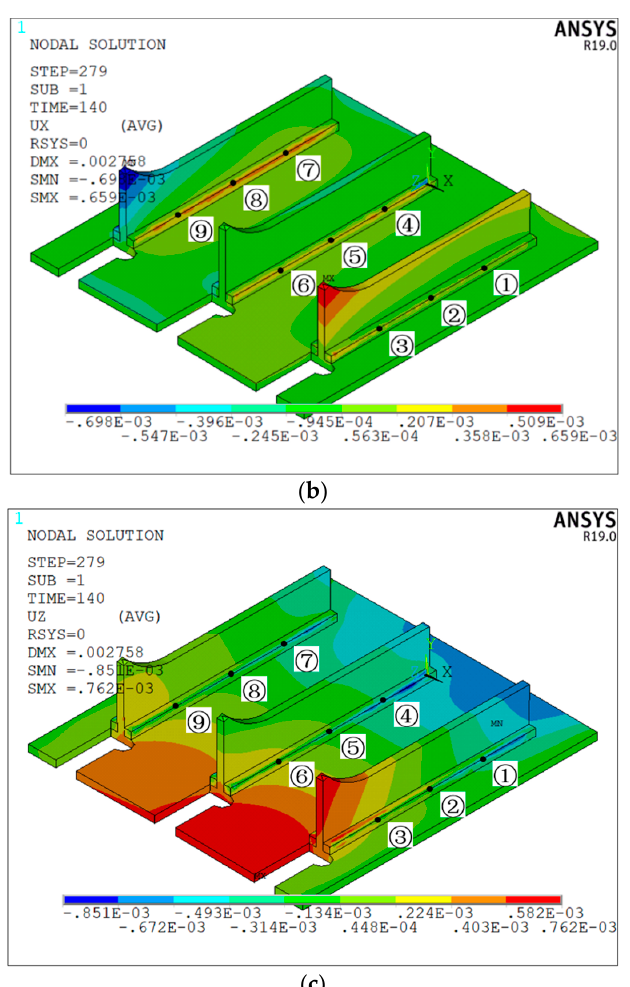
Figure 11. Deformation of welded structure 4 under the welding sequence of “ ①⑦③⑨②⑧④⑥⑤ ”: ( a ) total deformation cloud map; ( b ) deformation cloud map along the x -axis; ( c ) deformation cloud map along the z -axis.